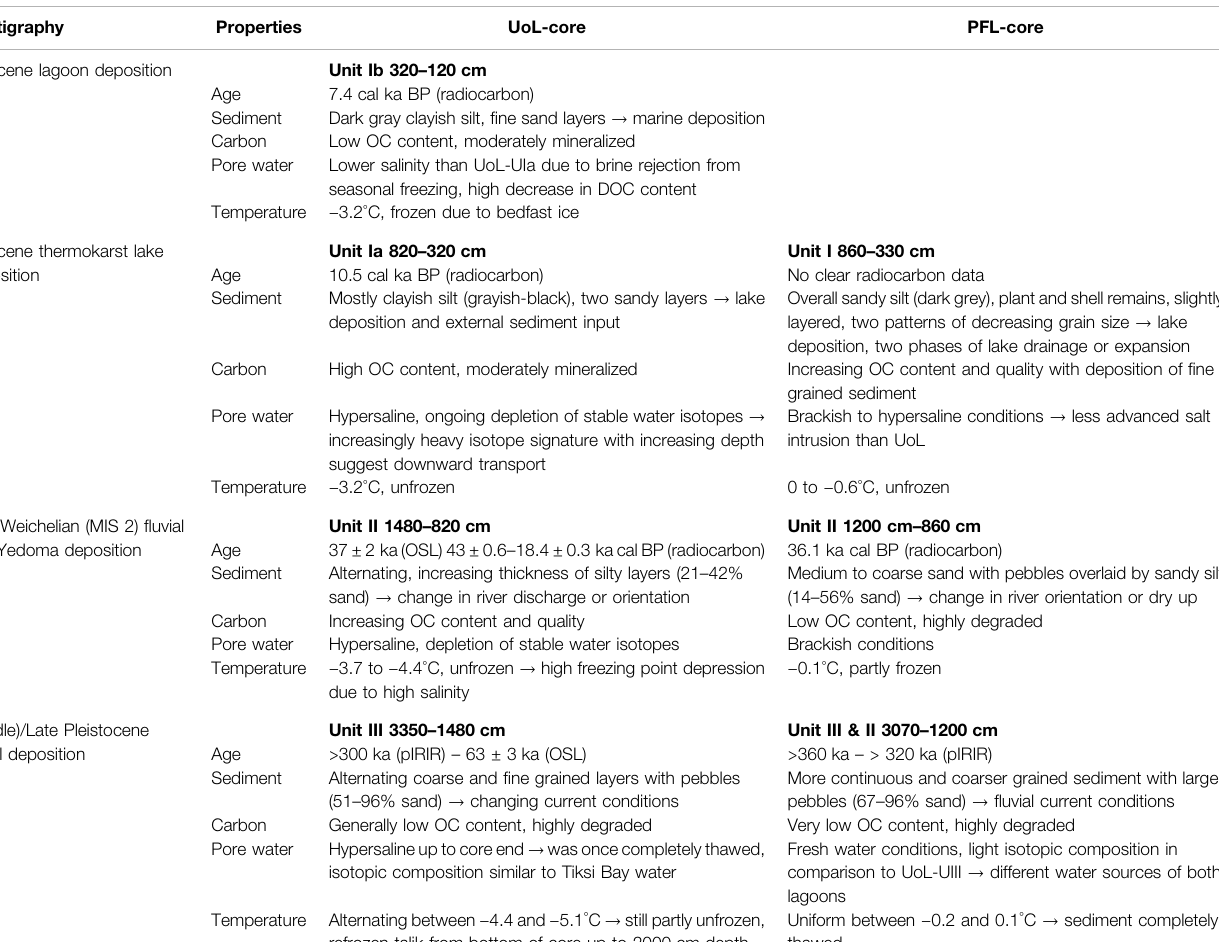
TABLE 3 | Summary of stratigraphy, geochrononoly, sedimentology, biogeochemistry, facies, temperature, and pore water hydrochemistry deduced from multiproxy records.